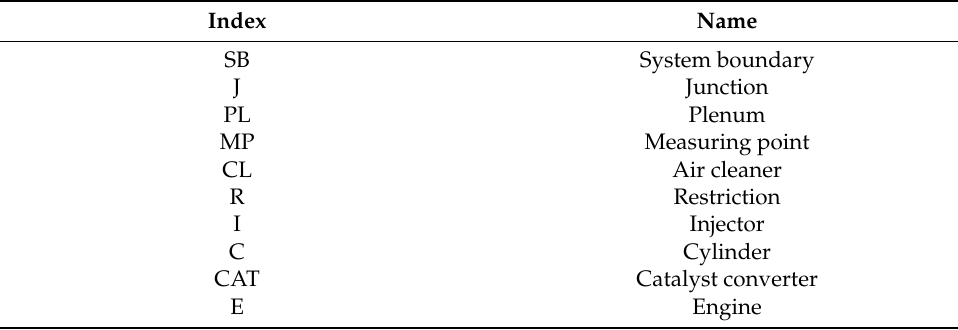
Table A1. The legend of indexes used in Figure